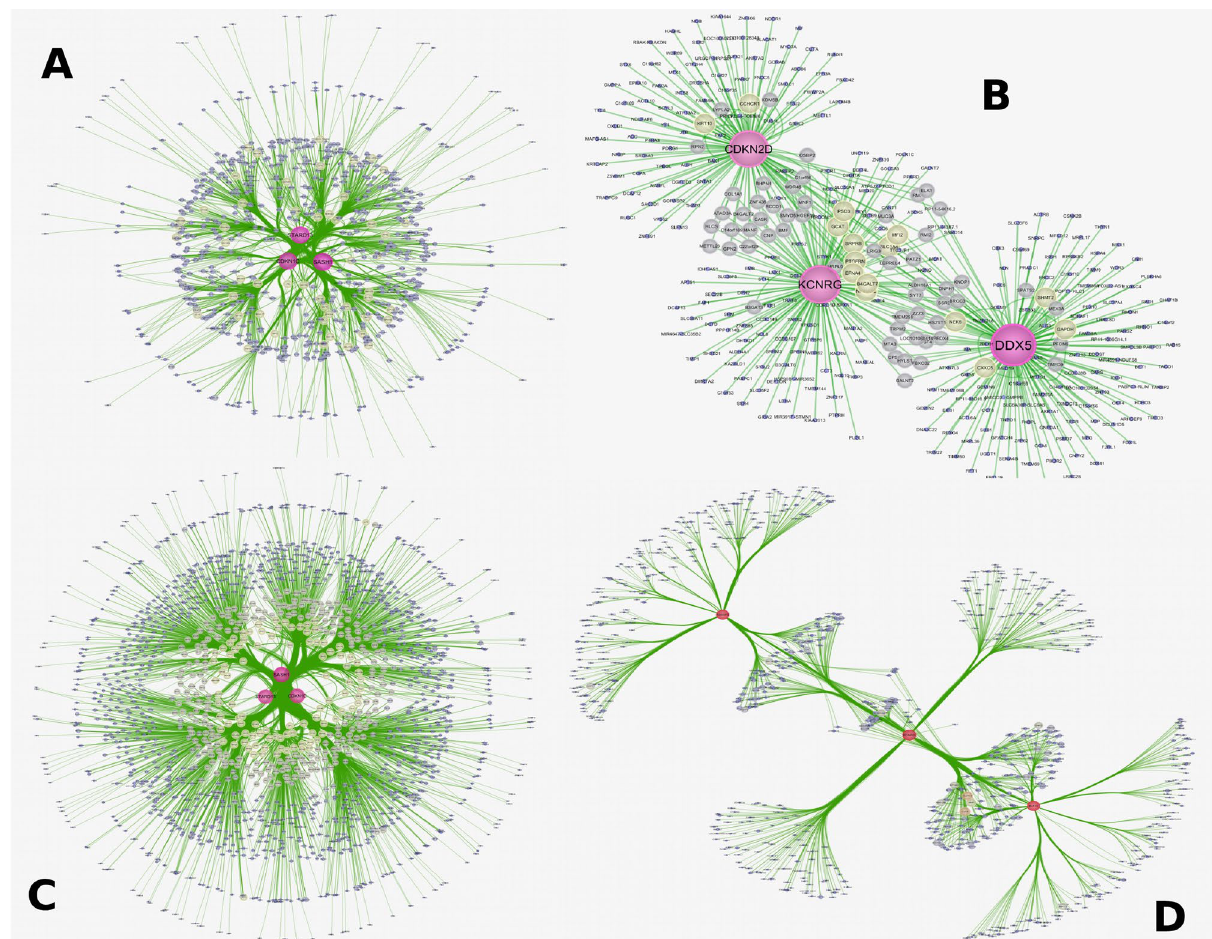
Figure 5. Correlation networks of tumor suppressor genes with DE genes. Examples for simple and complicated networks respectively constructed with correlations of three strong and weak TS genes with DE genes. ( A ) Negative correlation network of strong TS genes STARD13, CDKN1C, and SASH1 with DE genes at stage 2. ( B ) Negative correlation network of weak TS genes CDKN2D, KCNRG and DDX5 with DE genes at stage 2. ( C ) Positive correlation network of strong TS gene STARD13, CDKN1C, and SASH1 with DE genes at stage 2. ( D ) Positive correlation network of weak TS genes CDKN2D, KCNRG and DDX5 with DE genes at stage